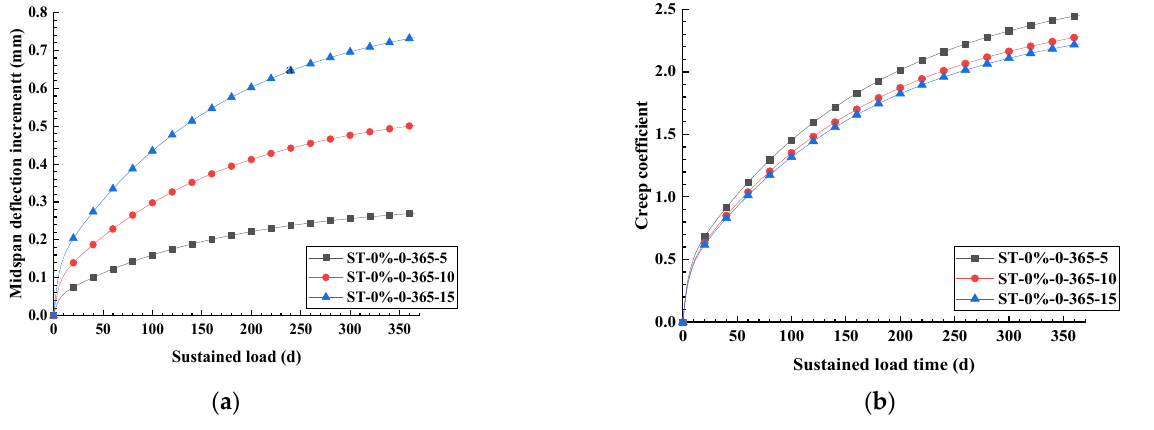
Figure 15. The ( a ) midspan deflection increment and ( b ) creep coefficient of the concrete beams under different stresses.